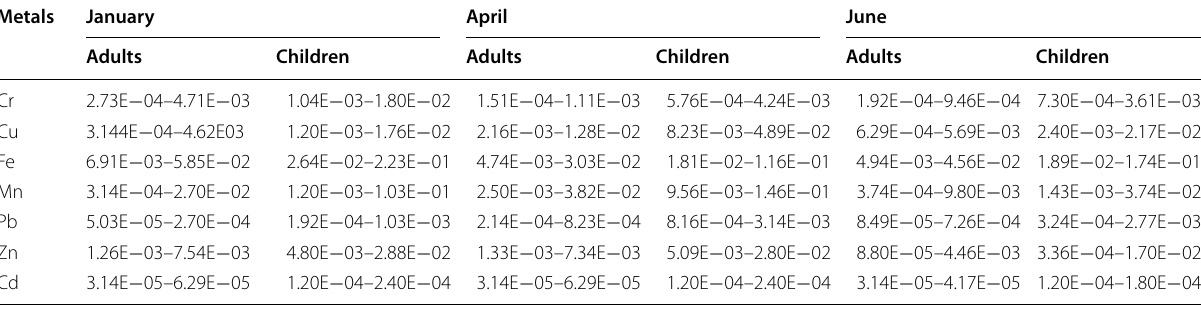
Table 6 Chronic risk assessment (CDI ) of heavy metals in groundwater samples taken around Muledane village ing through daily ingestion pathway during January, April and June for adults and children